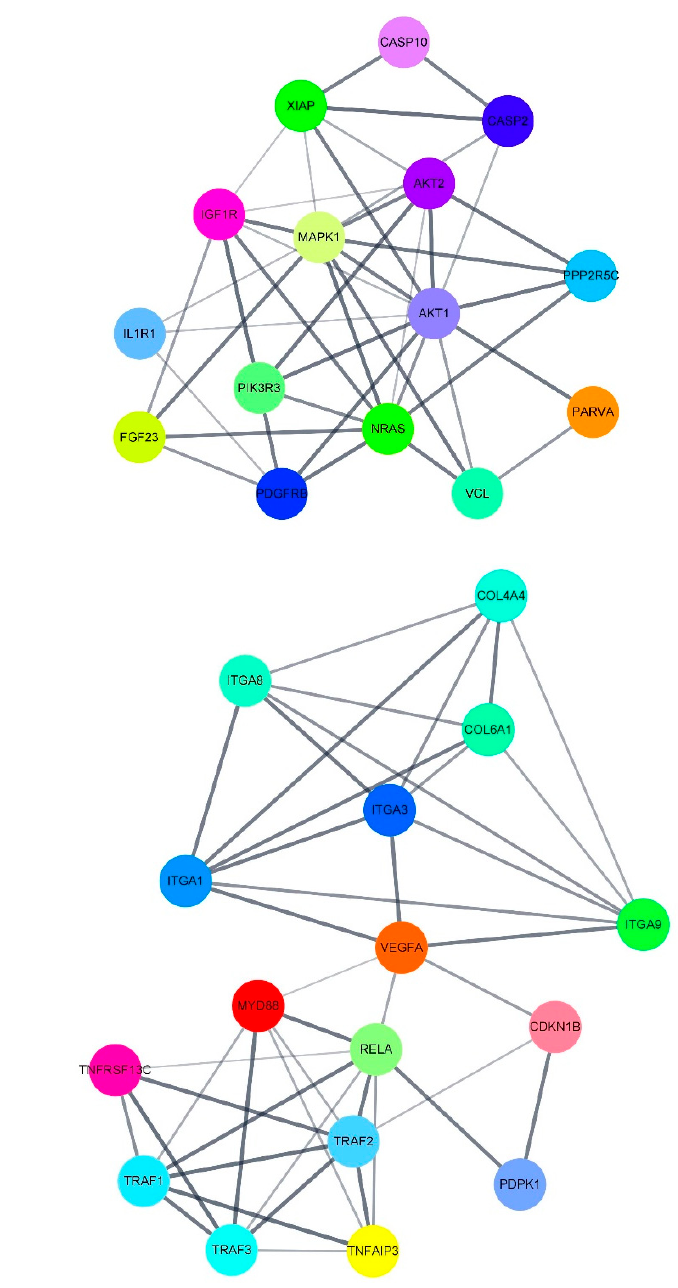
Figure 4. Identification of hub genes from the PPI network by using the MCODE algorithm. ( A , C ) represent the PPI networks of upregulated genes and downregulated genes, respectively. ( B ) (clustering score = 8) is the PPI network of hub genes extracted from ( A ). ( D ) (clustering score = 6) and ( E ) (clustering score = 5.73) are the PPI networks of hub genes extracted from ( C ). PPI: protein–protein interaction; MCODE: Molecular Complex Detection.